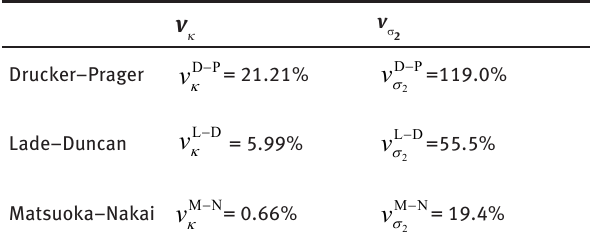
Table 7: Average relative difference of parameters κ and intermediate principal stress s , determined by the two approaches: 2 full set of principal stresses and Vikash and Prashant proposal, for Drucker–Prager, Lade–Duncan and Matsuoka–Nakai failure